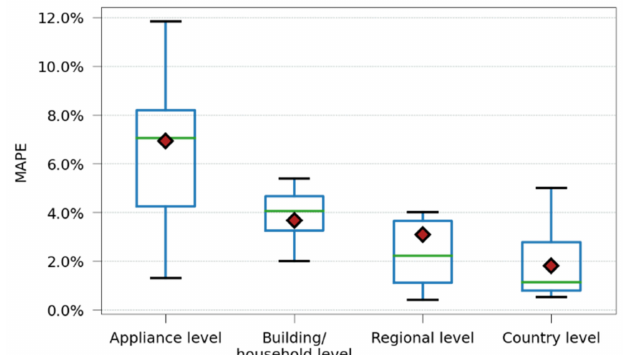
Figure 11. Boxplot of MAPE values by spatial levels of detail. The same mode of display as in Figure 10. This shows that a higher level of detail results in lower accuracy. This is because aggregated loads on the country and regional level are smoother and have stronger temporal patterns compared to loads of individual appliances or households, which are subject to behavioral patterns and a higher degree of